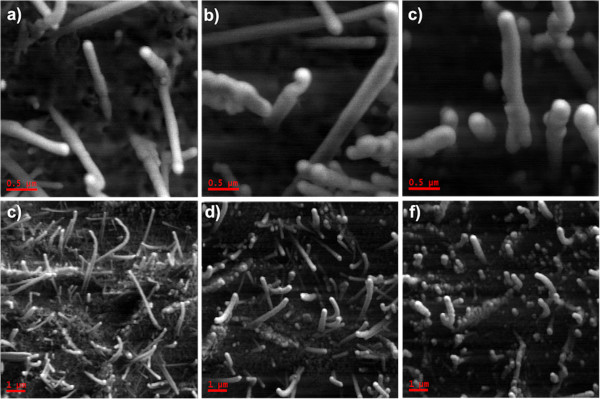
High-resolution SEM images. Showing the morphology of unirradiated ZnO NWs (a, b) and irradiated NWs with fluences of 1.5 × 1016 cm−2 (c, d) and 1017 cm−2 (e, f). Note the disappearance of the thinner NWs as the irradiation fluence increases.